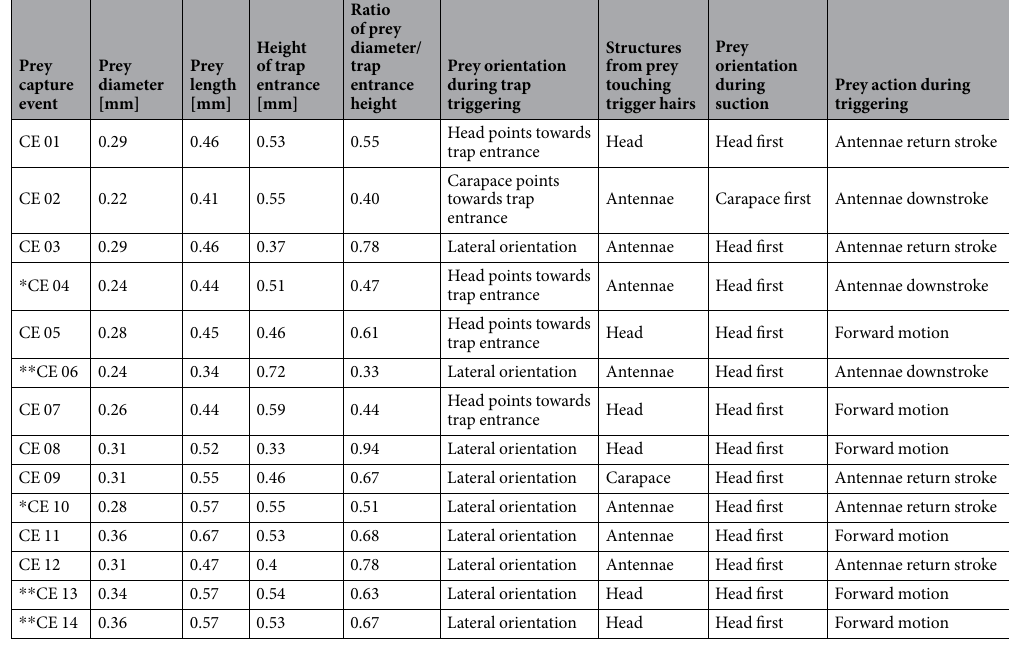
Table 1. Prey dimensions, trap entrance heights, and prey positions as well as prey behavior during triggering and suction. CEs marked by a single asterisk ( * CEs 04 & 10) or with a double asterisk ( ** CEs 06, 13, 14) occurred in the same traps,